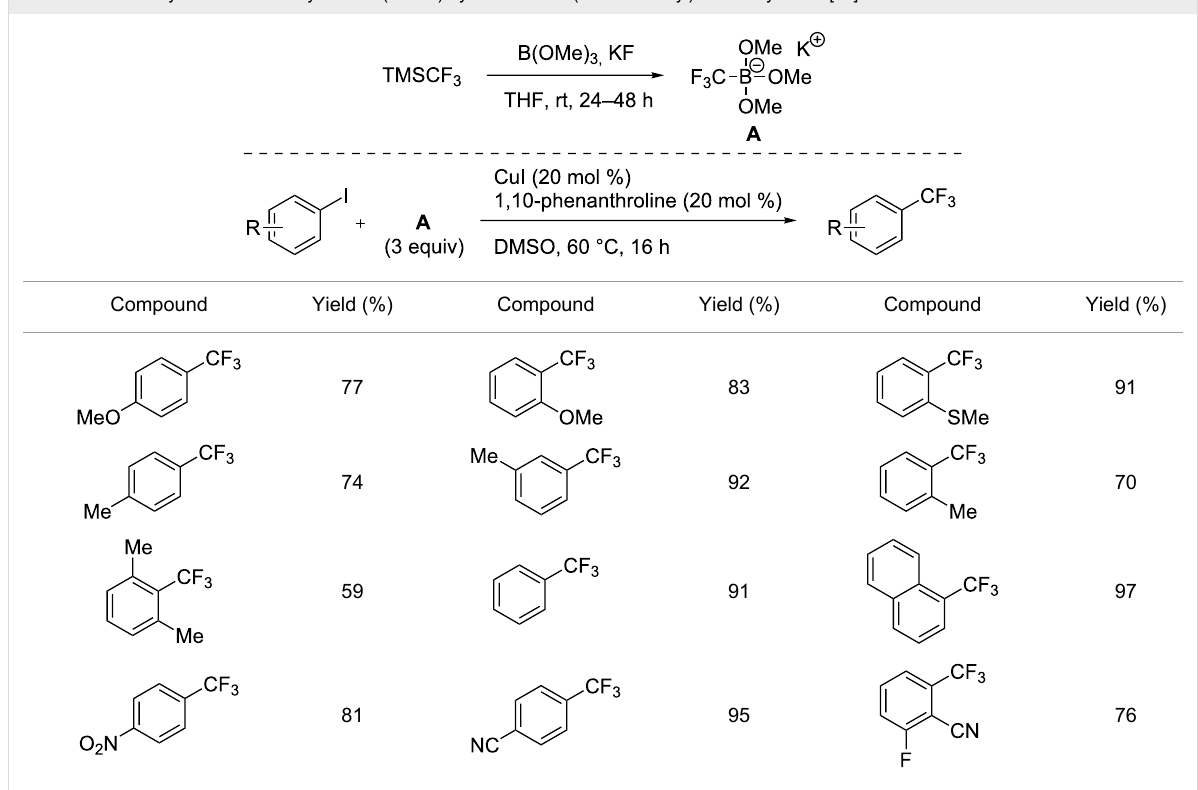
Table 13: Cu-catalyzed trifluoromethylation of (hetero)aryl iodides with (trifluoromethyl)trimethoxyborate [74].